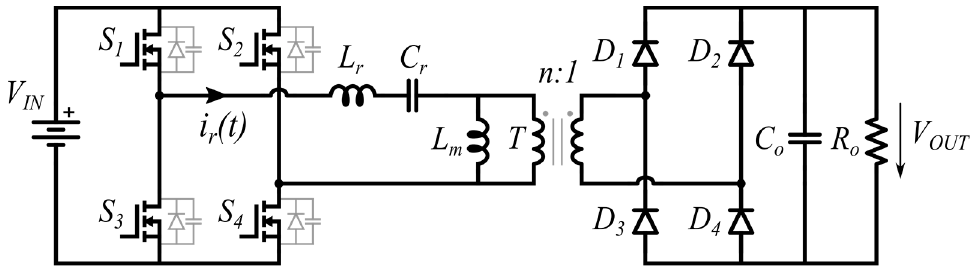
Figure 2. Isolated LLC full-bridge with full-bridge diode rectifier.